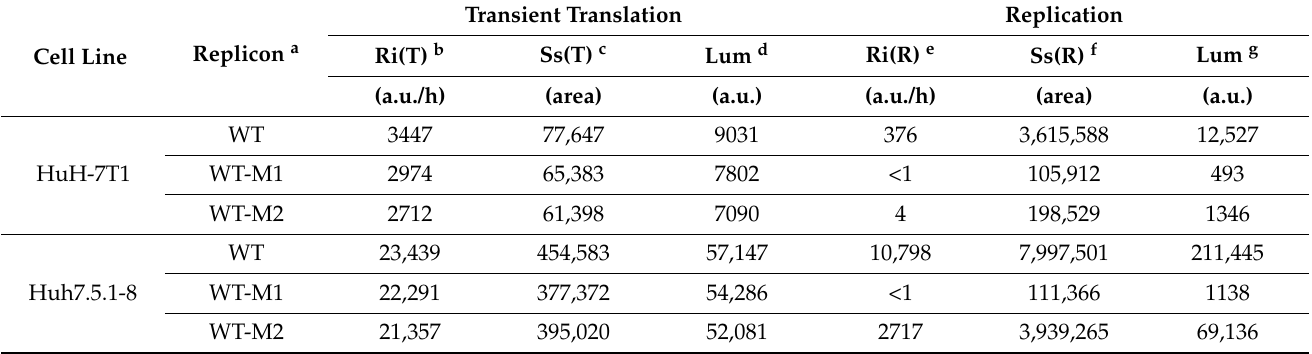
Table 3. Effects of mutations within 5 (cid:48) UTR of the replicon on bioluminescence profiles of transient translation and